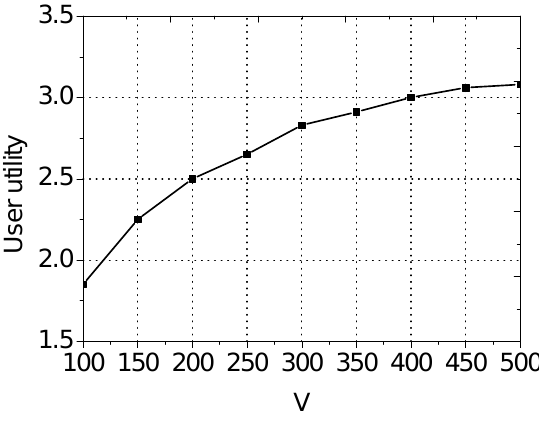
Figure 7. User utility versus